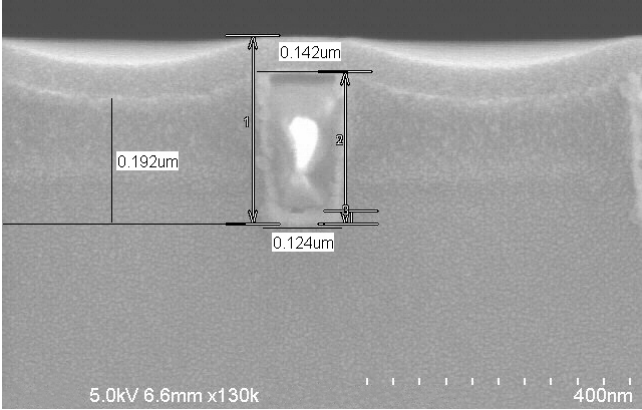
Figure 4. scanning electron microscope (SEM) picture of a single sample.